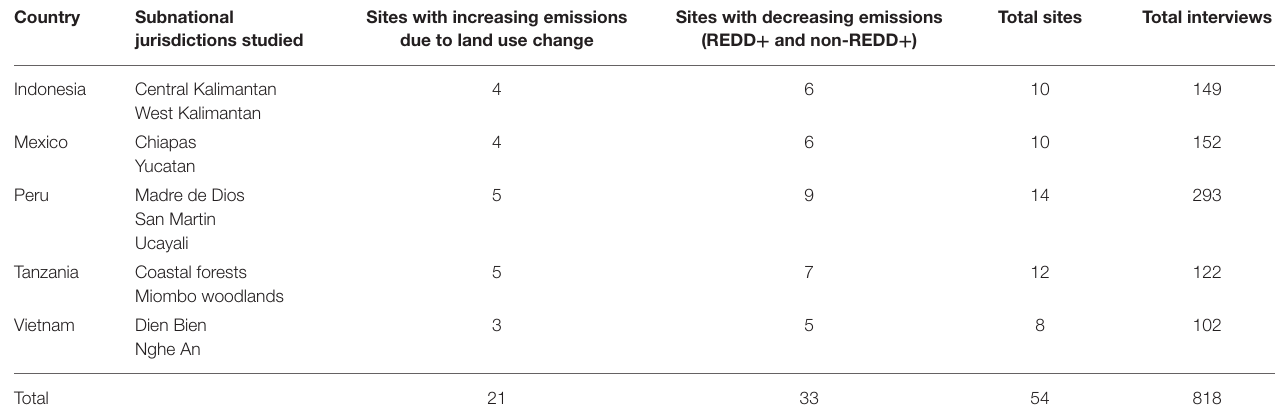
TABLE 1 | Study sites and interviews per country. Country